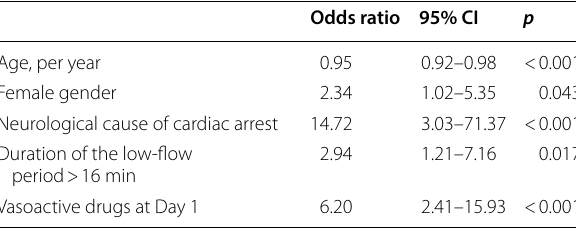
Table 3 Independent predictors of brain